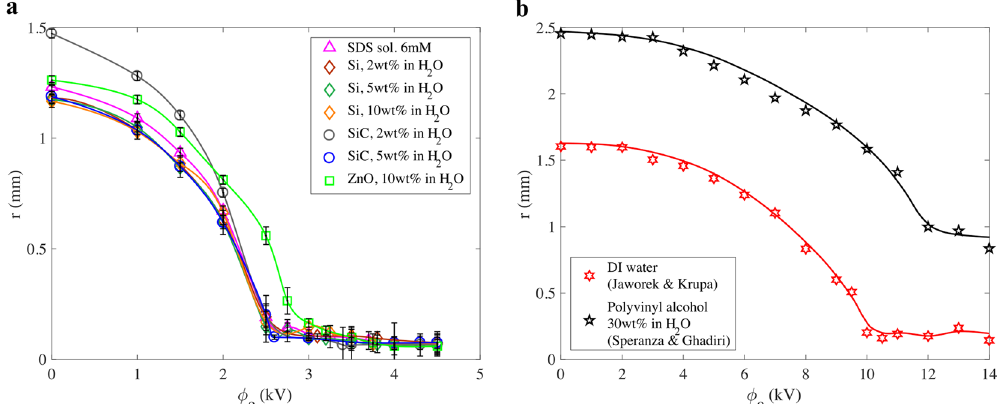
Figure 3. Droplet size vs applied electrical voltage. ( a ) Markers represent the average droplet radius as a function of the applied voltage between the capillary tube and the earthed electrodes. Error bars show the uncertainty of the measurements with a confidence interval of 95%. Solid curves are produced by curve fitting the experimental results. ( b ) Other investigators’ data. Jaworek & Krupa’s results 19 (red stars) are adapted from their Fig. 3a. Speranza & Ghadiri’s results 31 (black stars) correspond to their electrode configuration C. Solid curves are produced by curve fitting the experimental data.